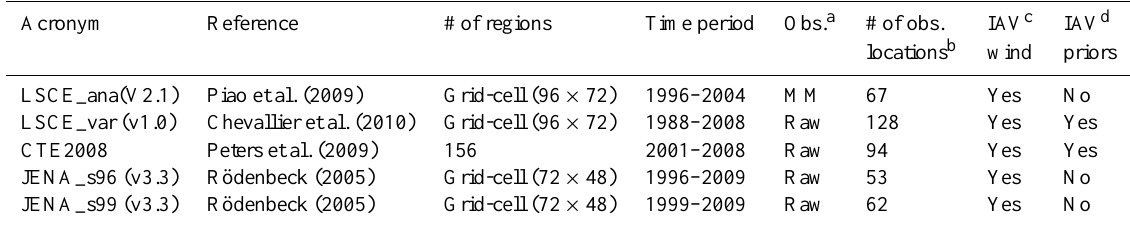
Table 5. Inversion systems used in this study and key attributes.